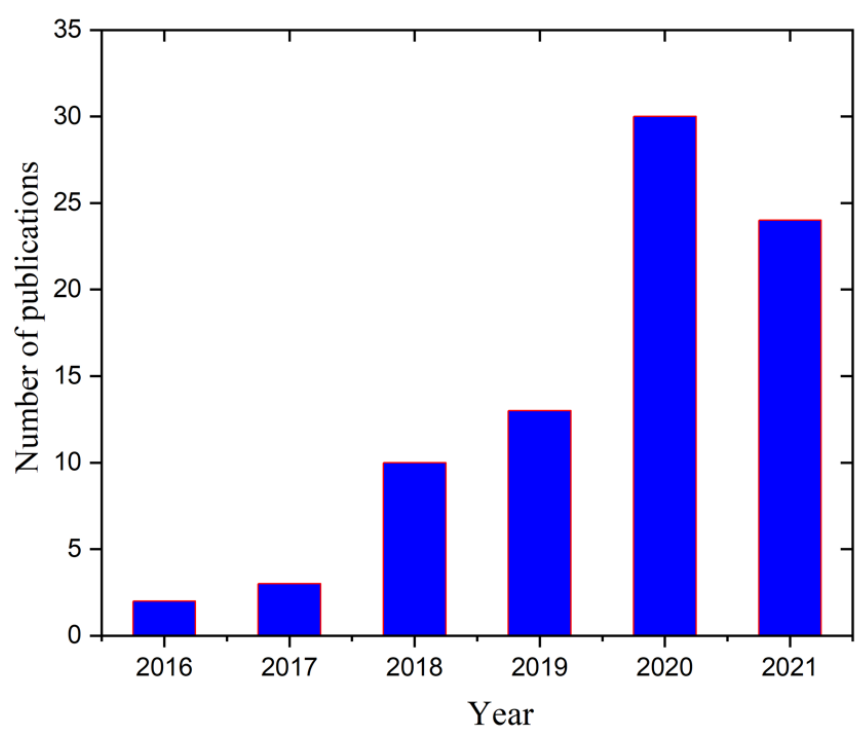
Figure 1. The number of published articles on “Welding of HEAs, 2016 to 2021 from the Web of Science.